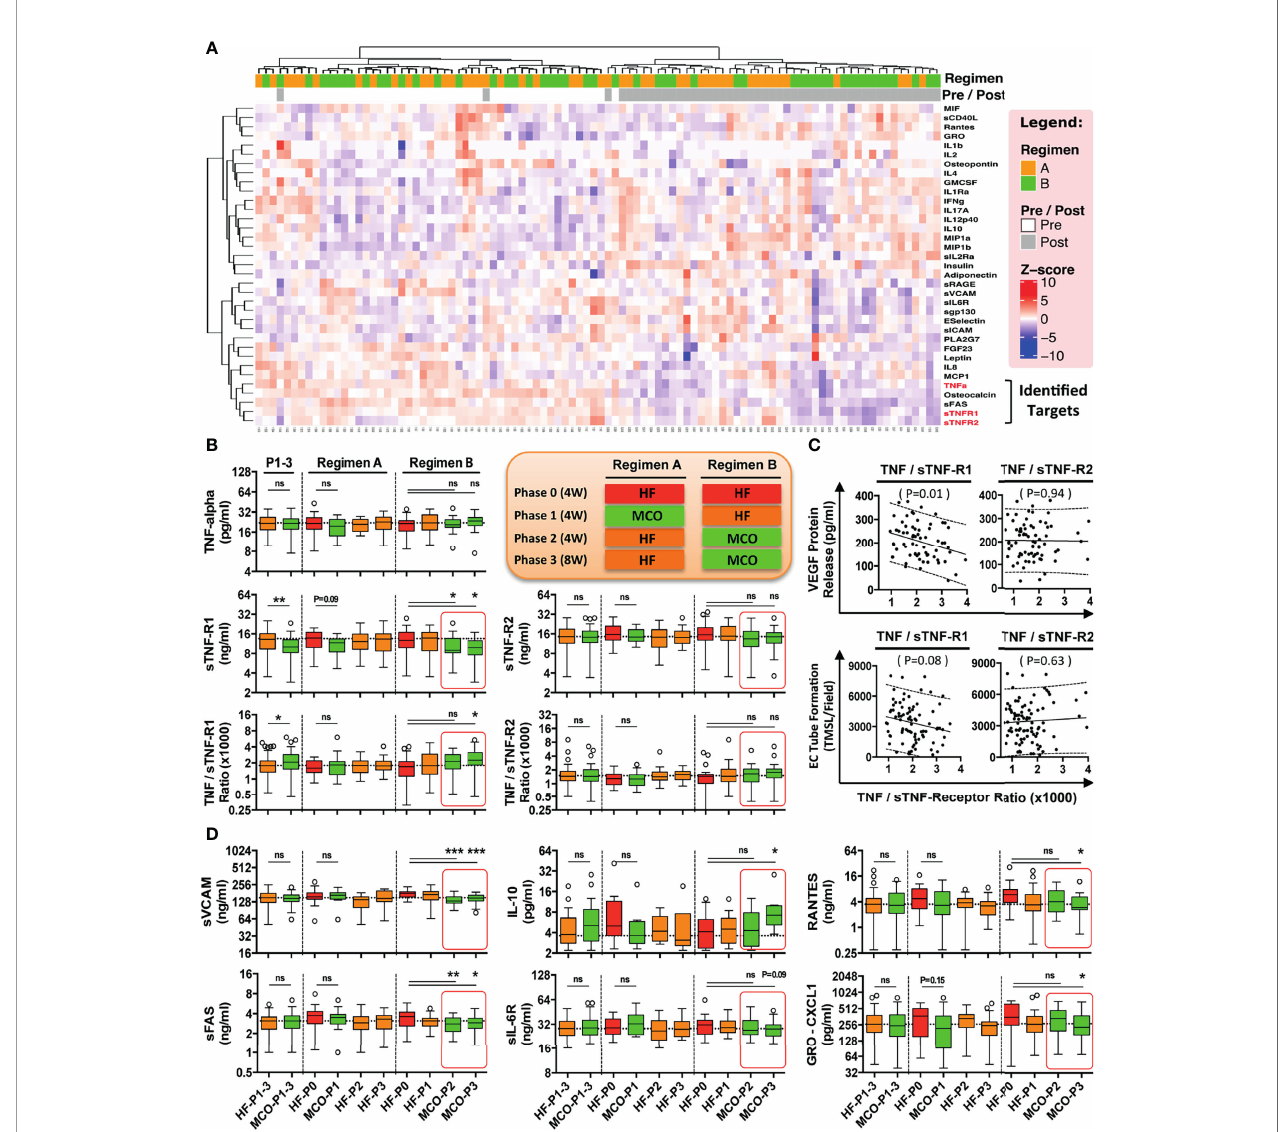
FIGURE 3 | MCO dialysis alters the systemic TNF- a /s-TNF-R1-ratio correlating with endothelial protection in vitro and a bene fi cial shift in serum cytokine levels in vivo . The patients underwent the two different hemodialysis (HD) regimes as indicated in (either HF/MCO/MCO or MCO/HF/HF; n=23-25) and the levels of soluble mediators at the different time points were analyzed with multiplex Milliplex and Luminex technology (28). (A) Unsupervised clustering heat-map analysis of biomarkers (rows) and patients (columns); (B) Quanti fi cation of TNF- a , and sTNF-R1 and sTNF-R1-R2 and their corresponding ratios; (C) Correlation of the TNF- a /sTNF-R1- and TNF- a /sTNF- R2-ratios with endothelial VEGF release (pg/ml) or endothelial tube formation (TMSL/ fi eld) upon stimulation with either 10% HF or 10% MCO patient serum; and (D) Patient serum pro fi ling for biomarkers of endothelial activation and systemic in fl ammation. [Legend to (B) and (D) ] Central legend (simpli fi ed depiction corresponding to the clinical trial scheme shown in ) indicates the underlying color code of the samples/time points in the box plots from regimen and the length of their phases (Phase 1 and 2 four weeks and phase 3 eight weeks, abbreviated as P1, P2, and P3 with duration shown in brackets), which show cytokine analysis of serum samples at the end of HF wash-in phase (Phase 0, the standard proin fl ammatory baseline before start of Regimen A or B which indicated in red), and the end of Phase 1, 2, and 3 (HF shown in orange, and MCO shown in green in legend and corresponding box plots), and the analyzed samples correspond to the end of the phases (Corresponding to the red stars in Figure 2A ). Each box plot is labeled with the corresponding dialysis fi lter device (HF or MCO) and the trial stage (P0, P1, P2, and P3), as indicate in the central legend. ANOVA, Box plots Tukey with interquartile range, with * P < 0.05, ** P < 0.01, and *** P < 0.001. ns, not signi fi